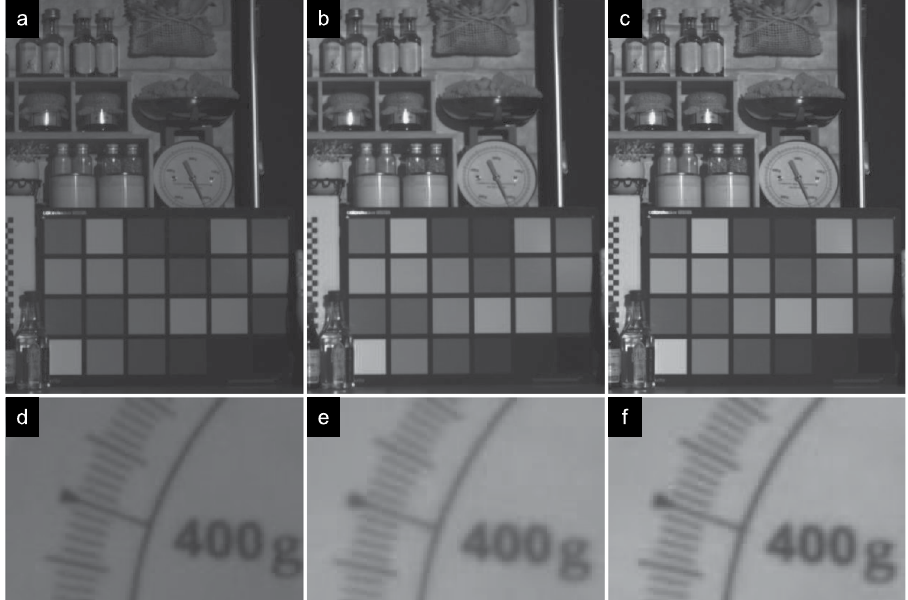
Figure 7. ( a – c ) Shows near-infrared images taken with the demo camera. An indoor scene is same to the visible images shown in Fig. 6. An IR pass filter which transmits only 700nm-1200nm is set in front of the lens. ( a ) A NIR image is taken with sample A. ( b ) A NIR is taken with sample B. ( c ) A NIR is taken with sample C. ( d – f ) Close up images of the scale shown in center of the upper panels ( a – c